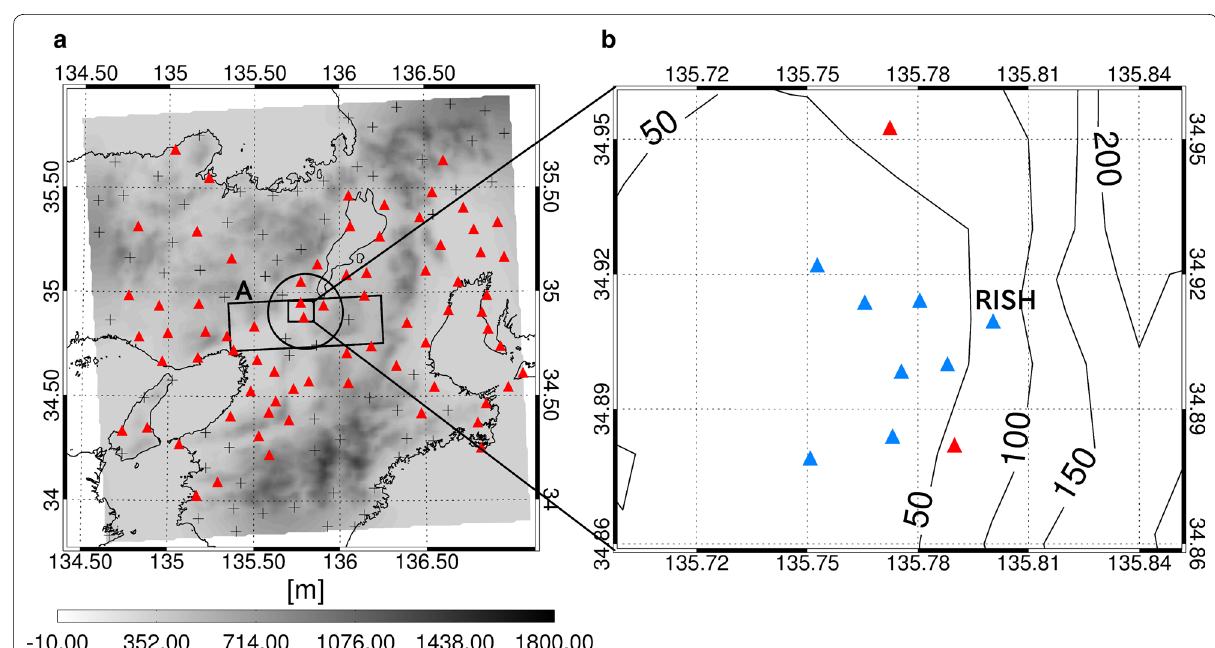
Fig. 1 a Simulation domain of inner model. Red triangles and plus symbols indicate selected and unselected GEONET stations for data assimilation, respectively. The rectangle A is the domain for evaluating the simulation accuracy of hourly accumulated rainfall amounts. Seven GEONET stations inside the circle and the GNSS stations of the Uji network were used to investigate the spatial inhomogeneity of PWV. b The dense GNSS receiver network around Uji, Kyoto, Japan. Blue and red triangles indicate stations of the Uji network and GEONET, respectively. Contour lines indicate eleva- tions of the ground (m). A rain gauge was installed at RISH